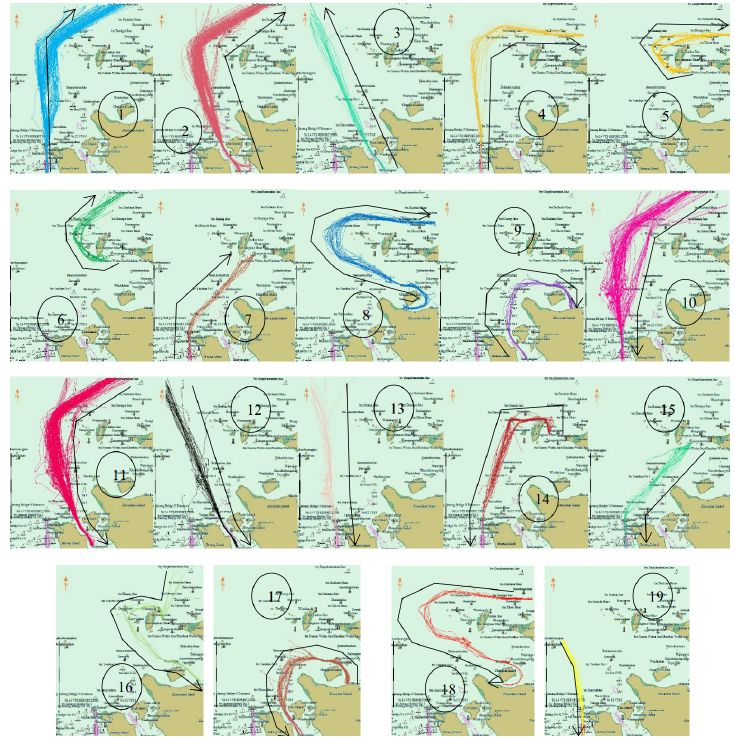
Figure 10. Cluster decomposition before navigation prohibition. There are fifteen clusters, black lines represent their shape and direction. Clusters 9 and 10 cross the bridge area.